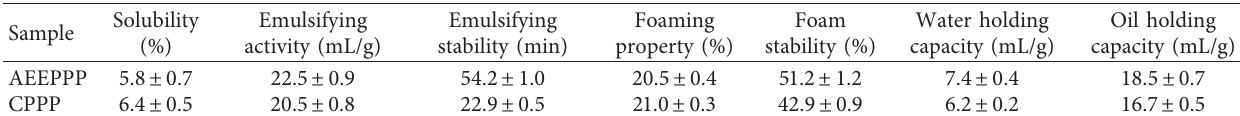
Table 5: Functional properties of peanut protein powder.